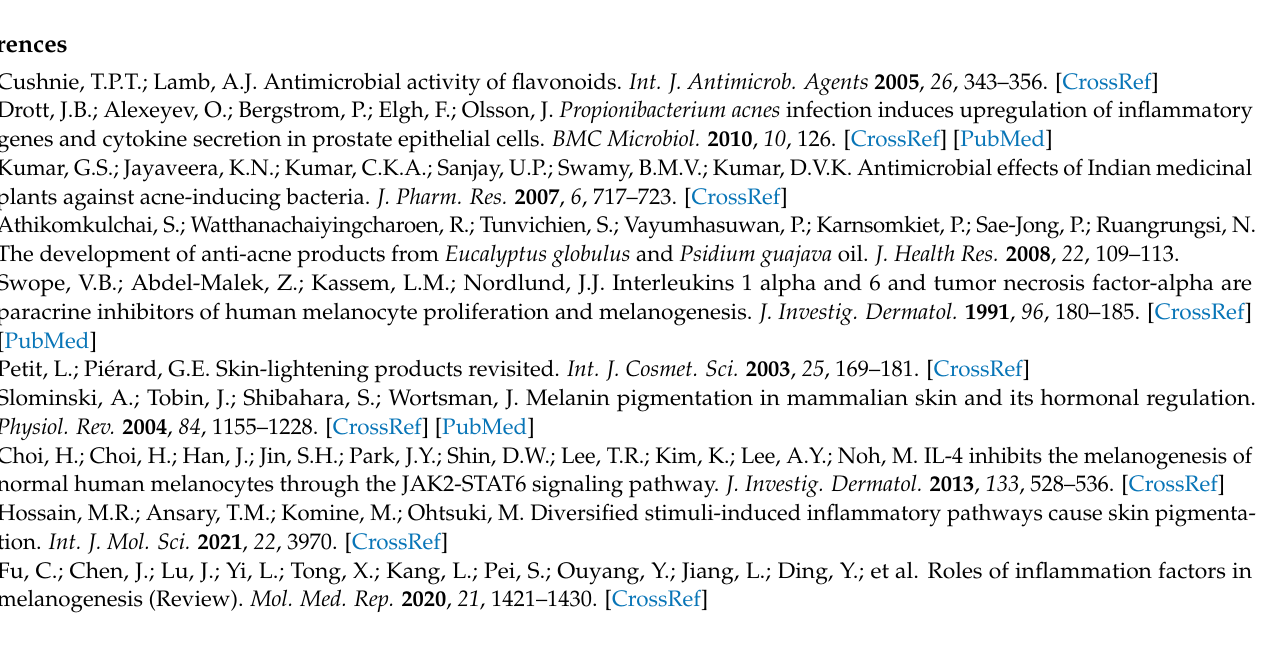
Figure S7: HMBC spectrum of ω -hydroxymoracin C; Figure S8: IR spectrum of moracin M (KBr disc); Figure S9: 1 H NMR spectrum of moracin M; Figure S10: 13 C NMR spectrum of moracin M; Figure S11: IR spectrum of moracin C (KBr disc); Figure S12: 1 H NMR spectrum of moracin C; Figure S13: 13 C NMR spectrum of moracin C; Figure S14: IR spectrum of 3, 4, 3 (cid:48) , 5 (cid:48) -tetrahydroxybibenzyl (KBr disc); Figure S15: 1 H NMR spectrum of 3, 4, 3 (cid:48) , 5 (cid:48) -tetrahydroxybibenzyl; Figure S16: 13 C NMR spectrum of 3, 4, 3 (cid:48) , 5 (cid:48) -tetrahydroxybibenzyl; Figure S17: IR spectrum of piceatanol (KBr disc); Figure S18: 1 H NMR spectrum of